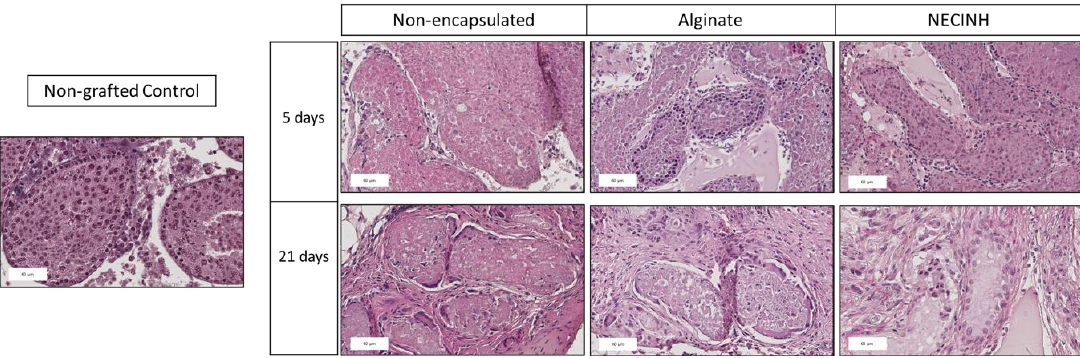
Figure 5. Impact of NECINH-nanoparticles-(NPs) loaded hydrogel on mice testicular tissue after autotransplantation for 5 and 21 days. Hematoxylin-eosin staining was used for the morphological evaluation of seminiferous tubules sections. Scale bar = 60 μm.